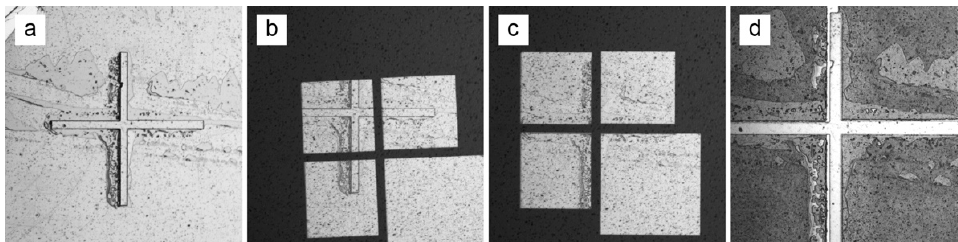
Figure 2. Mask alignment. ( a ) First layer features are visible through the second layer dry film photoresist. ( b ) Rough alignment of the second layer photomask by eye. ( c ) Fine photomask alignment performed under the microscope. ( d ) Following exposure and development, the final multilayer features are revealed. Here, the arms of the crosshairs are 125 µm wide, and thus misalignment is roughly 40 µm both horizontally and vertically. Scratches and smears are visible since the alignment marks were placed along the wafer edge and washing during development was focused on the center of the wafer where the functional devices are located.